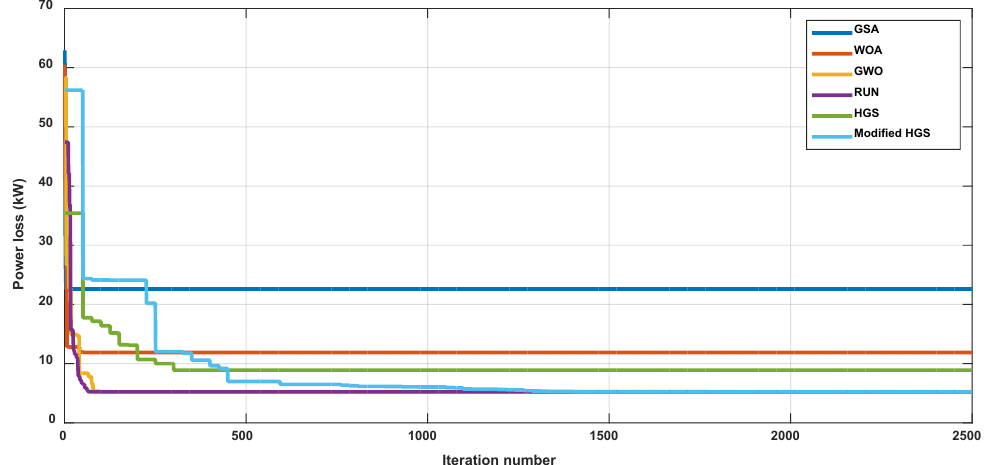
Figure 9. Variation in power loss with iteration numbers of different optimizers applied to the IEEE 69-bus.